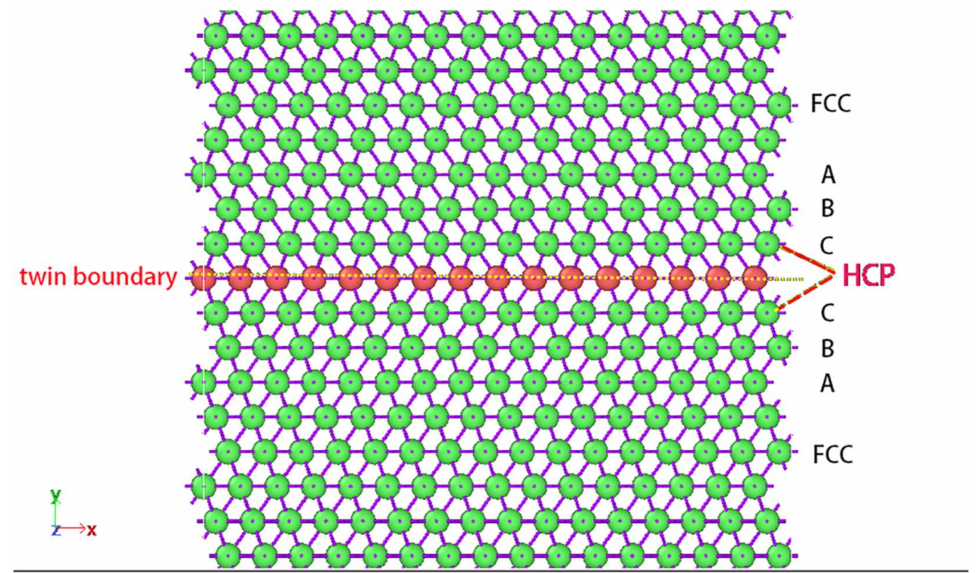
Figure 9. The arrangement of carbon atom layers in contact twinning of diamonds is mirrored and the lattice type at the twin boundary is a hexagonal close-packed